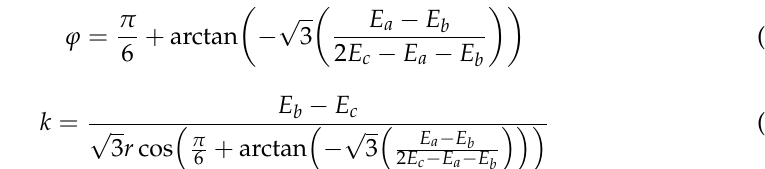
Figure 3. Section of the FBG sensing point whilst bending.